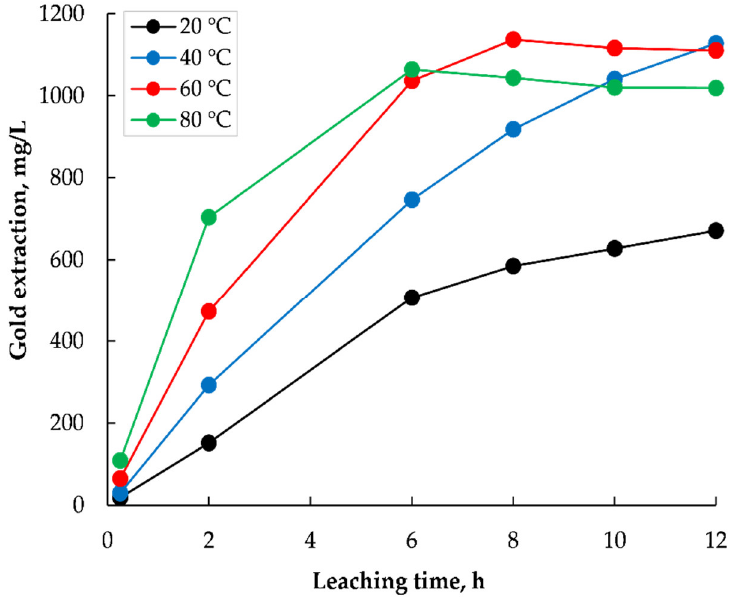
Figure 6. Gold extraction as a function of leaching time under different temperatures.